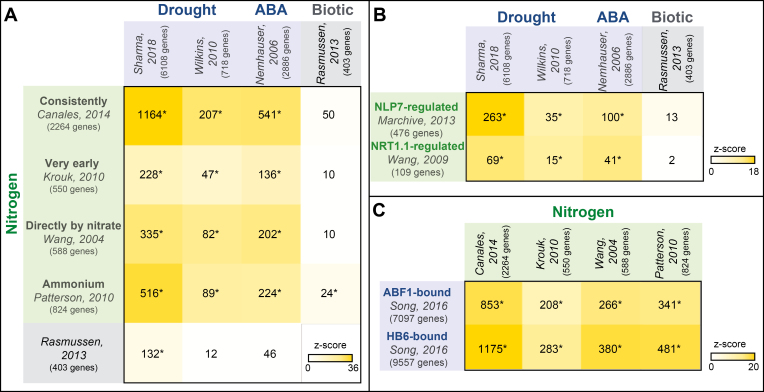
N and W are convergent signals at the transcriptomic level. Four published data sets of N-regulated genes in Arabidopsis were collected. These data represent (i) genes consistently regulated by N across independent studies (Canales et al., 2014); (ii) very early N-regulated genes identified in a time-series experiment (Krouk et al., 2010); (iii) genes directly regulated by nitrate (Wang et al., 2004); and (iv) genes regulated by ammonium (Patterson et al., 2010). N-regulated genes were compared with two independent data sets of drought-regulated genes in Arabidopsis (Wilkins et al., 2010; Sharma et al., 2018); one data set of ABA-responsive genes (Nemhauser et al., 2006); and one data set of genes responsive to biotic stress (included here as a negative control) (Rasmussen et al., 2013). Intersect results of N-regulated genes with drought, ABA, and biotic response gene sets are presented as a heatmap, where both the number of genes and the significance of the overlap are indicated (*Monte-carlo P<0.001) with the z-score value for each comparison). (A) Genes regulated by N are highly enriched in drought and ABA-responsive genes. (B) N-response genes regulated by the master TF of the N-response NLP7 (Marchive et al., 2013) or the nitrate transceptor NRT1.1/NPF6.3 (Wang et al., 2009) are highly enriched in drought- and ABA-responsive genes (Nemhauser et al., 2006; Wilkins et al., 2010; Sharma et al., 2018). (C) ABA-responsive genes that are bound by the TFs ABF1 or HB6 (Song et al., 2016) are highly enriched in N-regulated genes (Wang et al., 2004; Krouk et al., 2010; Patterson et al., 2010; Canales et al., 2014).